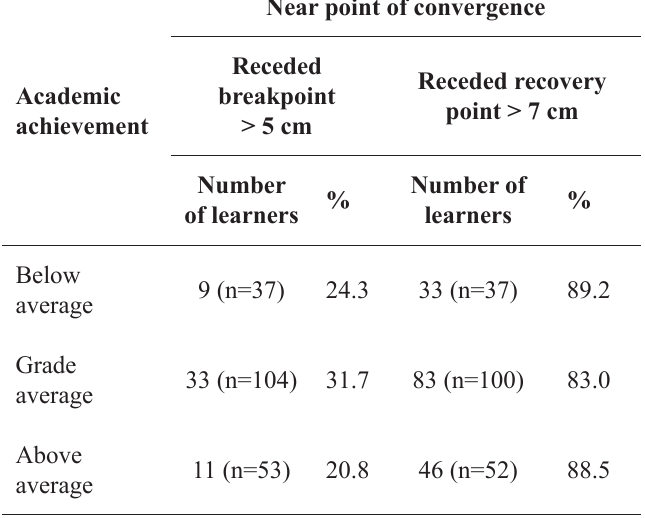
Table 4: Near point of convergence associated with academic achievement .